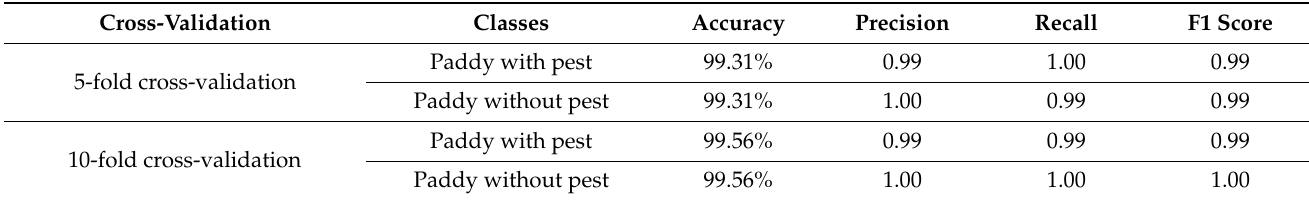
Table 6. Classification outcomes using the suggested model.